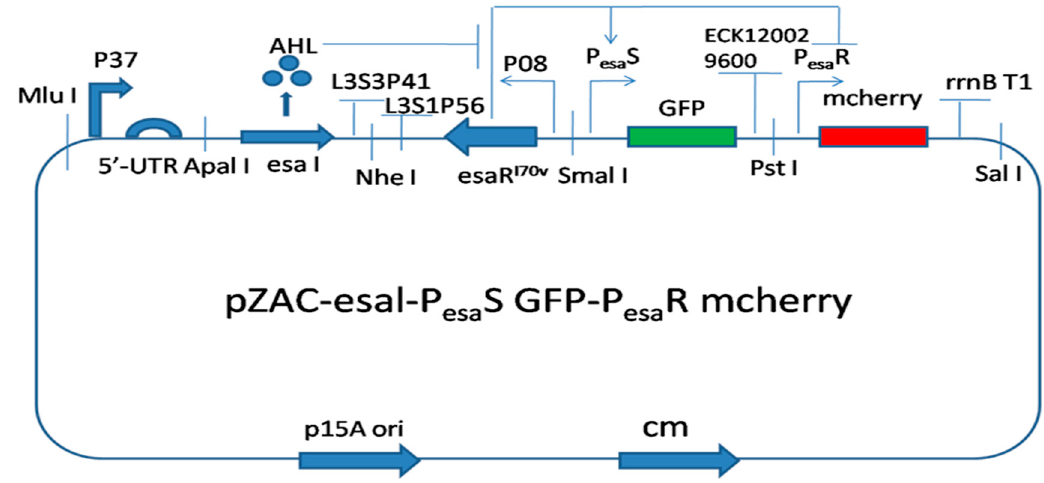
Figure 8. Both red and green fluorescent protein ( mCherry and GFP genes) probe the density of bacteria. The promoter of the GFP gene (PesaS) respnods to low density of bacteria. The promoter of mCherry gene (PesaR) responds to high density of bacteria.